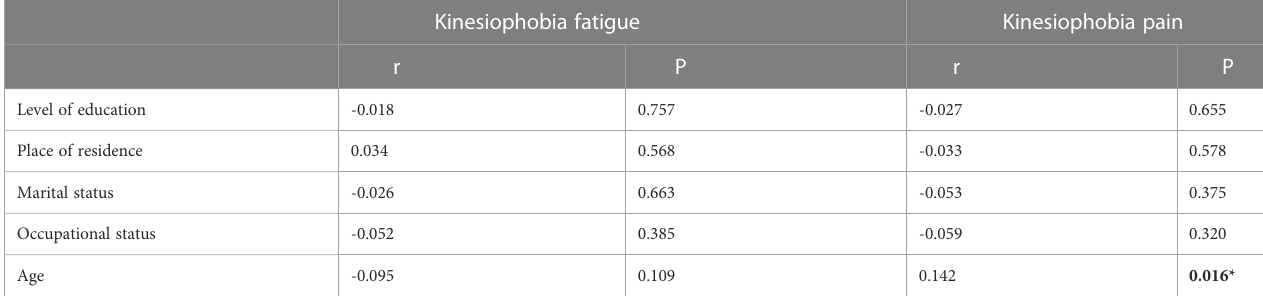
TABLE 9 Correlation of Kinesiophobia scores with sociodemographic variables; r: The Spearman ’ s rank correlation coef fi